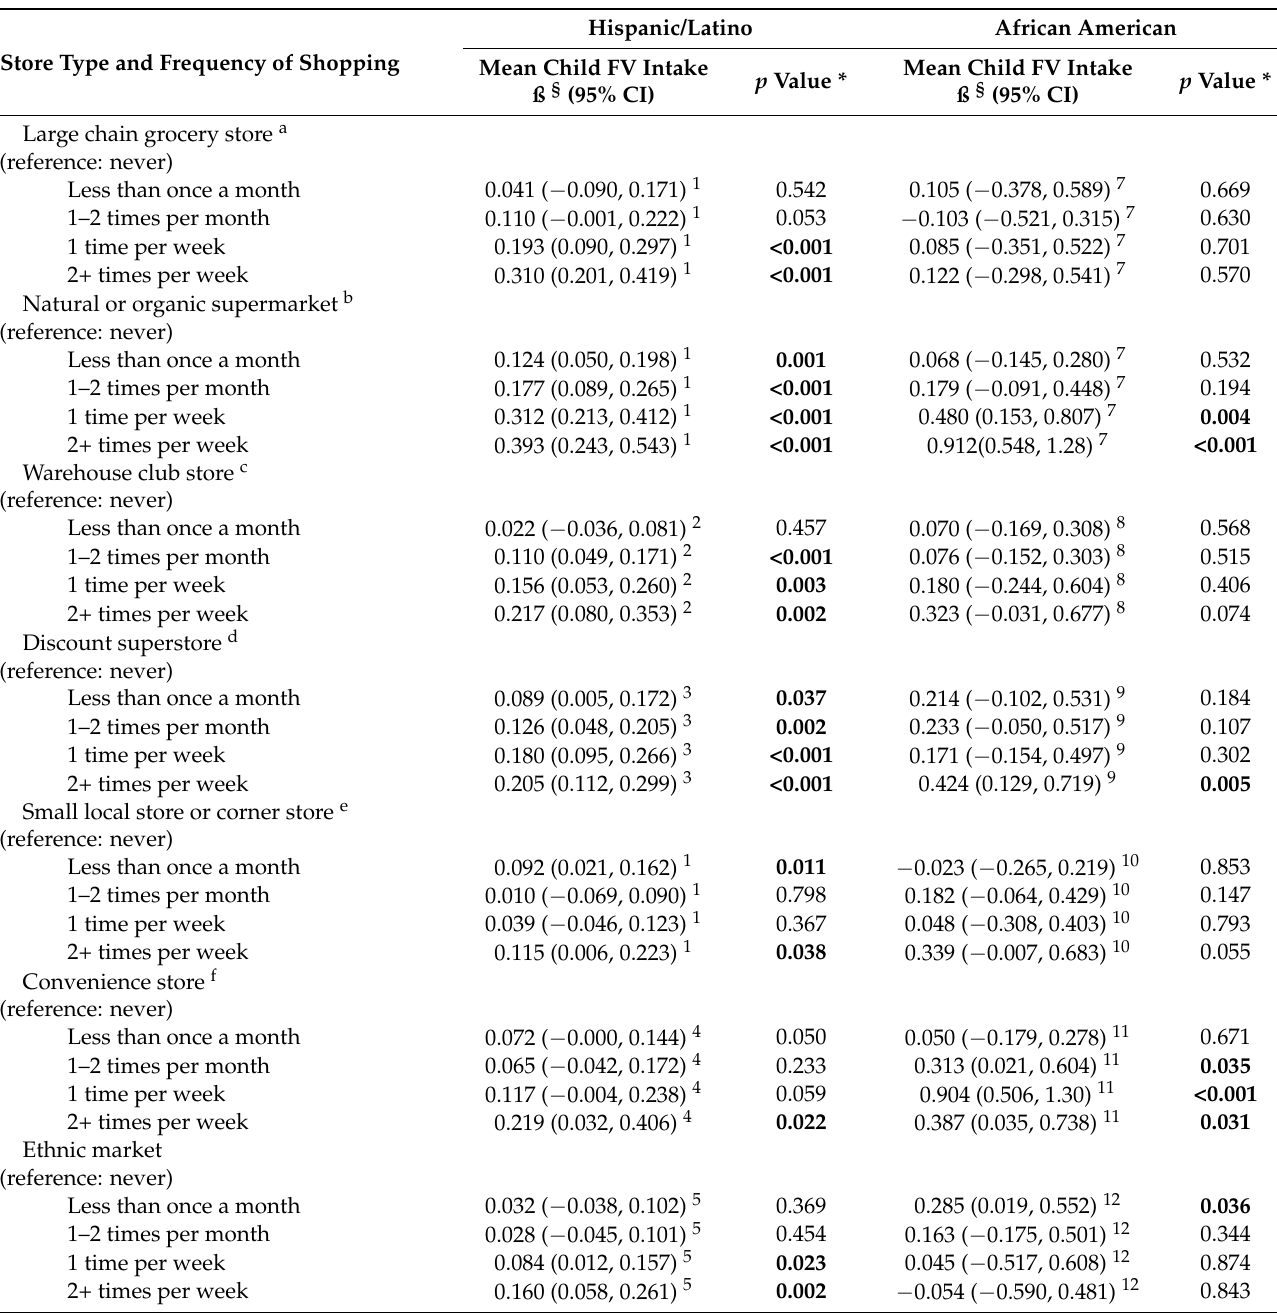
Table 3. Association Between Fruit and Vegetable (FV) Food Shopping Patterns and Child FV intake, Stratified by